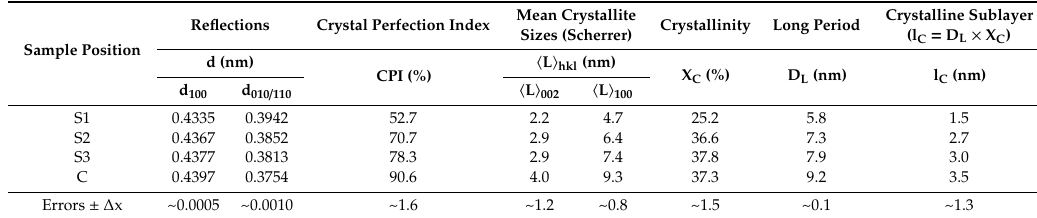
Table 1. Determined values for selected reflections: position, perfection, crystallite size, crystallinity, long period, and crystalline sublayer (WAXS and SAXS